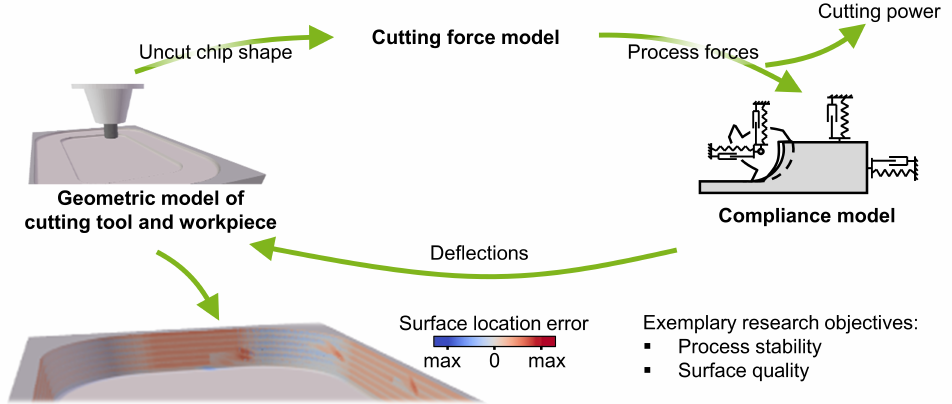
Figure 3. Function and operation of the geometric physically-based machining process